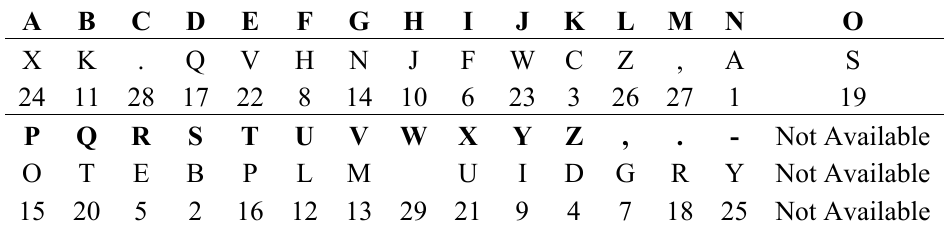
Table 6. A substitution Σ of 29 characters.